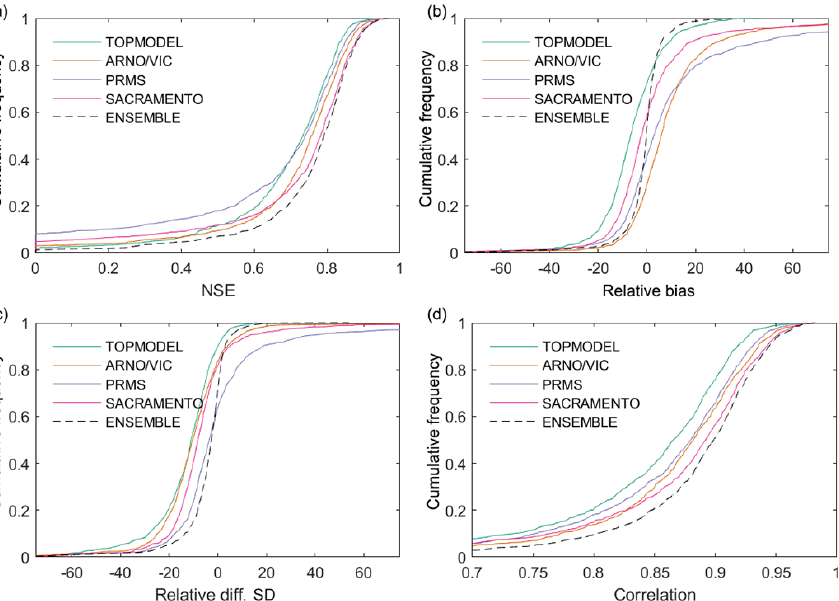
Figure 4. Distribution of model performance across all catchments for all four individual model structures and the model structure ensemble. Each plot shows model performance assessed using a different metric. (a) shows model performance assessed using Nash–Sutcliffe efficiency, (b) shows model relative bias or relative error in simulated mean runoff (%), (c) shows relative error in the standard deviation of runoff (%), and (d) gives correlation between observed and simulated